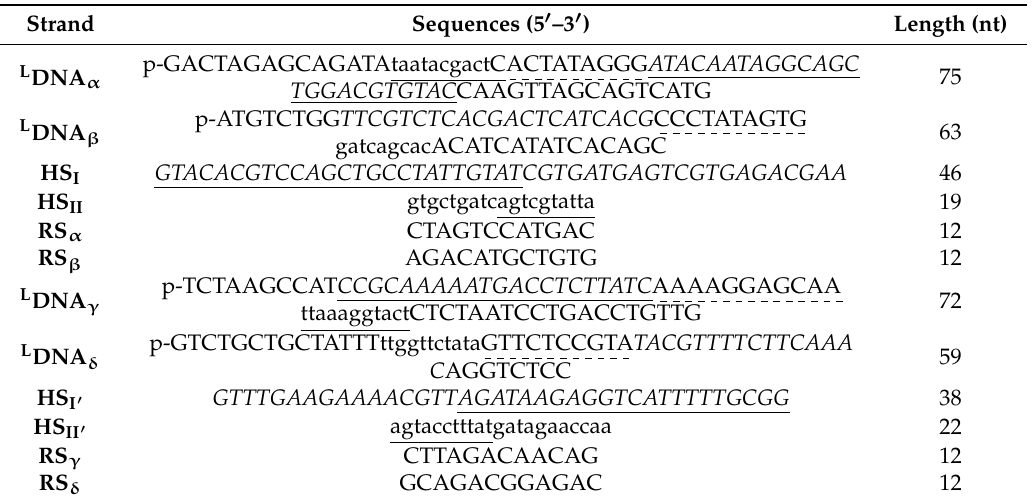
Table 1. Sequences of oligonucleotides used